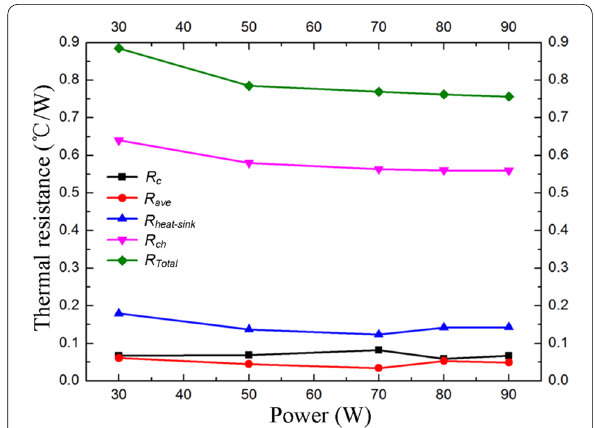
Figure 11 Thermal resistances under different input